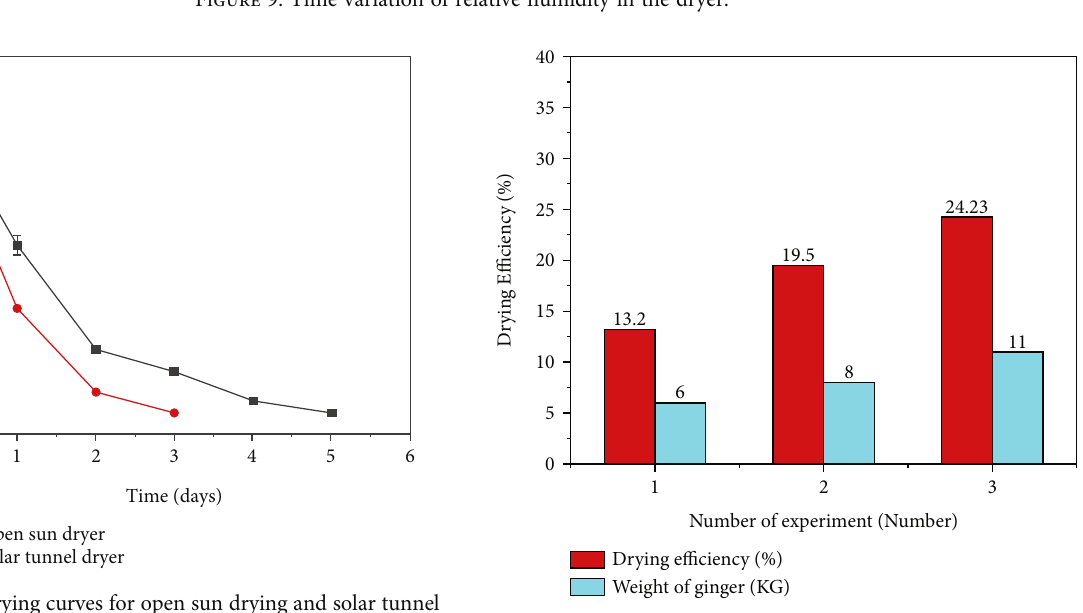
Figure 9: Time variation of relative humidity in the dryer.